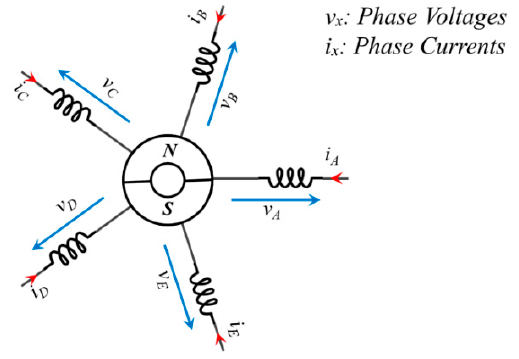
Figure 1. The winding topology of a five-phase permanent-magnet synchronous motor.